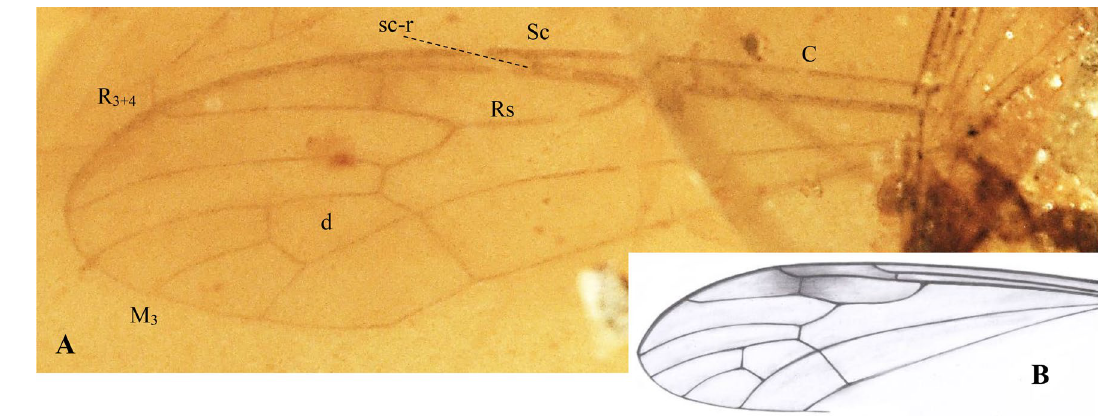
Figure 2. Antodicranomyia azari Perrichot, Nel and Krzemiński, 2007 23 , No. IGR.ARC-259 (male),